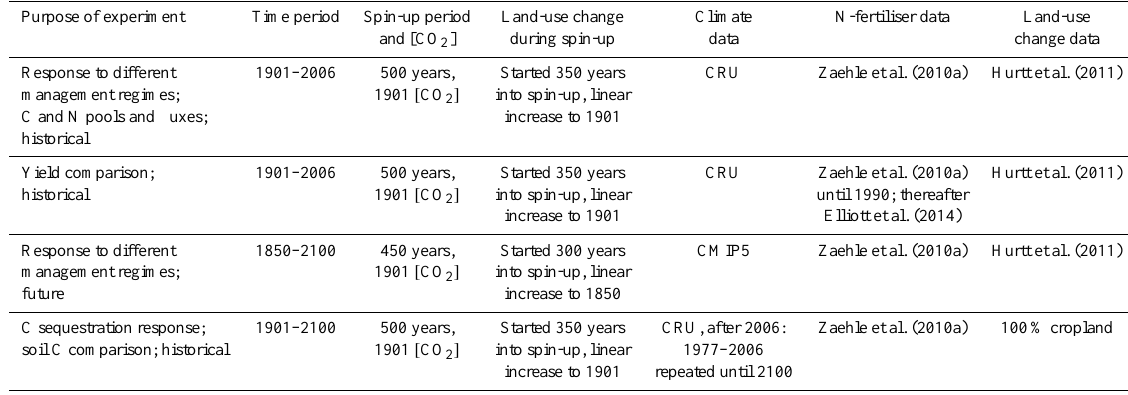
Table 1. Summary of simulation experiments; for abbreviations and further explanations, see text. Purpose of